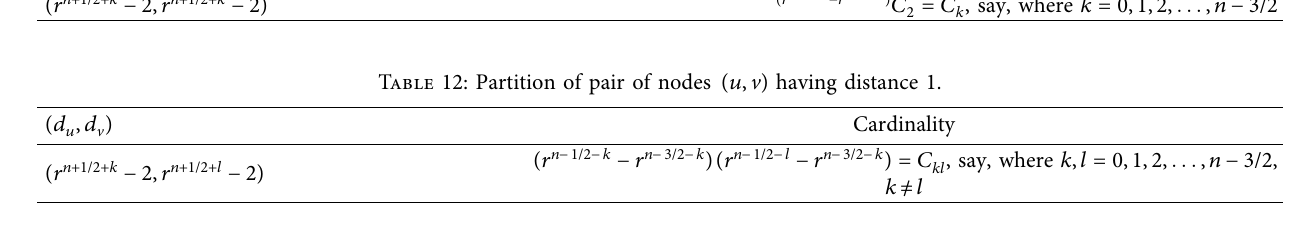
Table 13: Partition of pair of nodes ( u, v ) having distance 1.